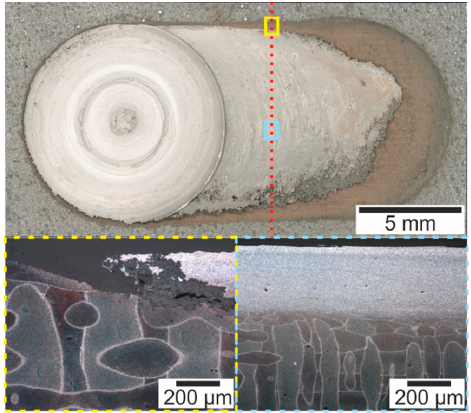
Figure 8. UW-FSP sample after corrosion testing. Top: Macroscopic documentation; Bottom: Cross-sections perpendicular to processing direction within the boundary region (left) and middle of the FSP zone (right).